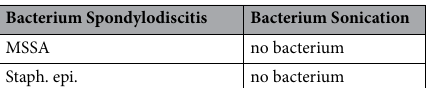
Table 6. Bacteria detected in sonication of explanted titanium. After sonication of explanted loosened titanium screws no bacterium was detected. MSSA = Methicillin sensible Staphylococcus aureus ; Staph. epi. = Staphyloccous epidermidis.